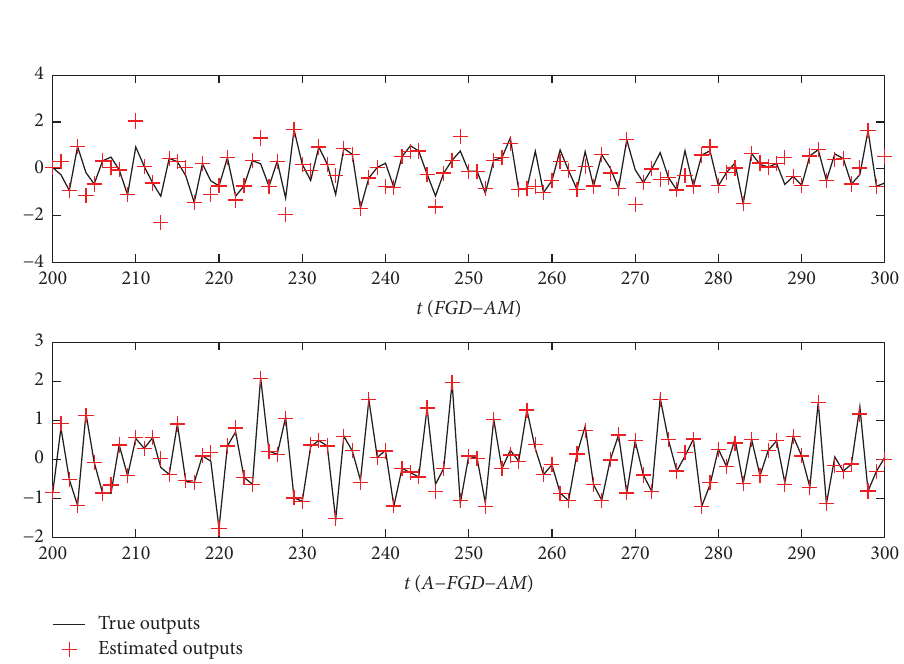
Figure 9: Te true outputs and estimated outputs ( c � 2 . 01/ λ